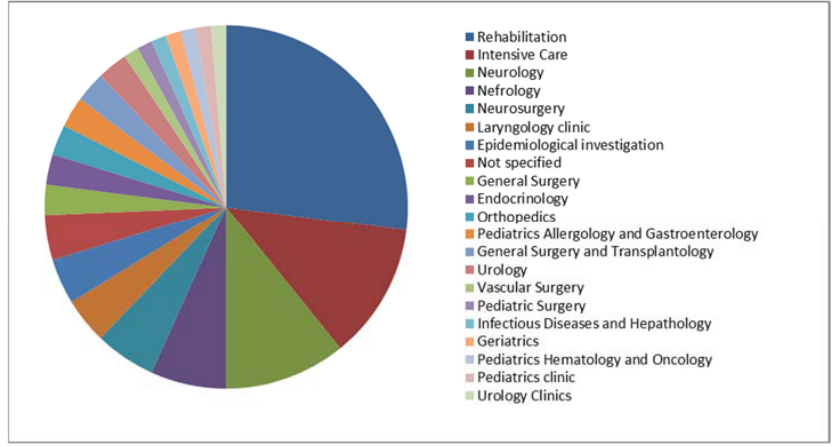
Figure 1. The origins (units) of the multidrug-sensitive P. aeruginosa strains included in the study ( n = 74).